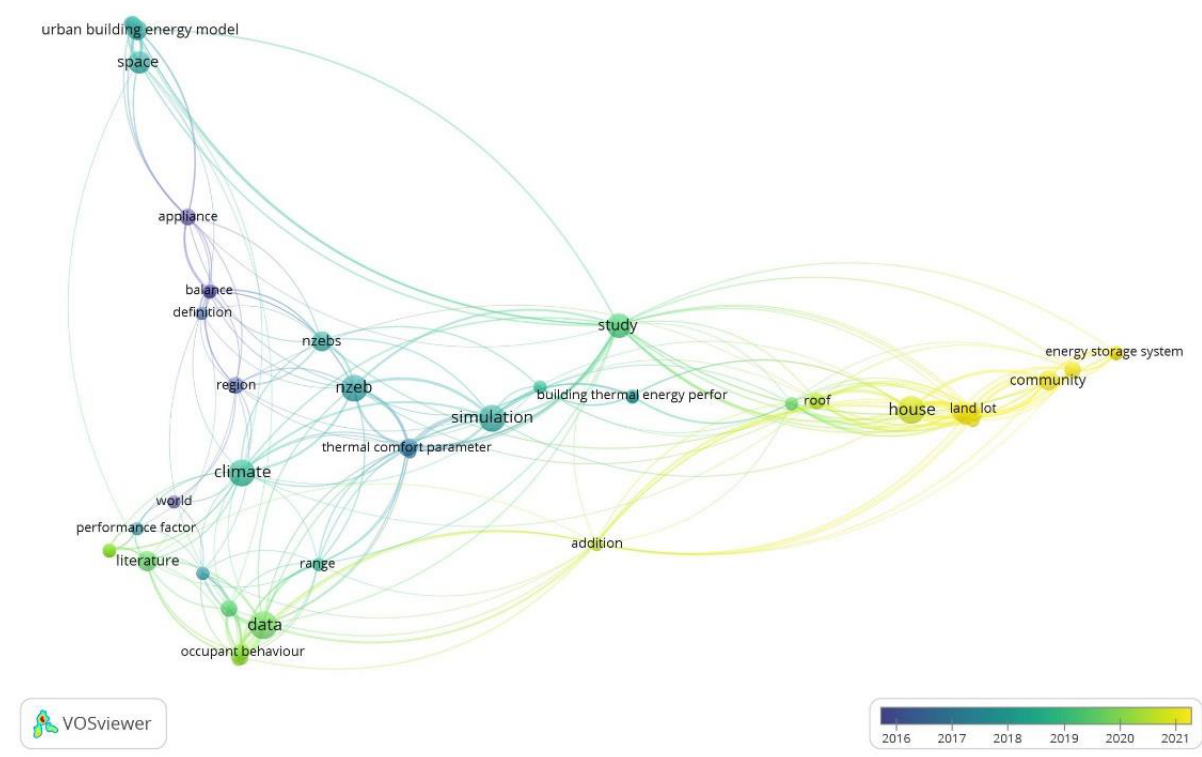
Figure 2. Overlay visualization by the average publication year of main terms in the literature review. Own elaboration in VOSViewer software version 1.6.18.0.